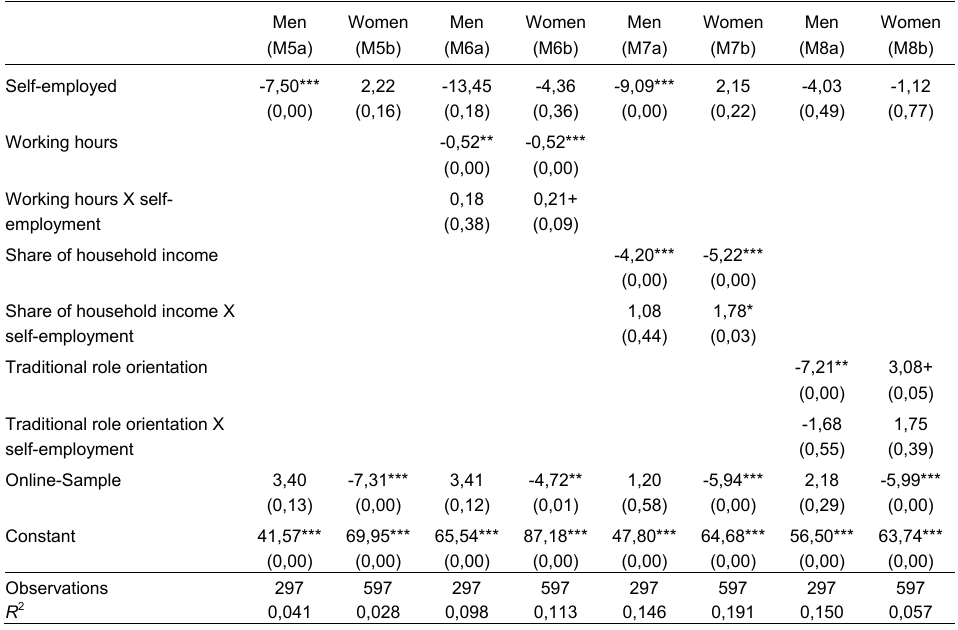
Table 3 : Linear regression on housework (Focus: